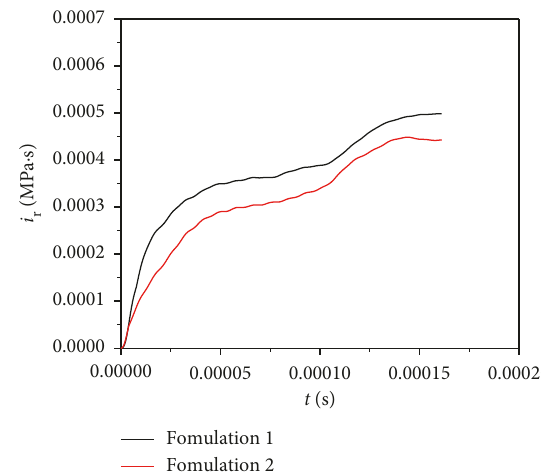
Figure 6: Impulse-time curve of the first incident shock